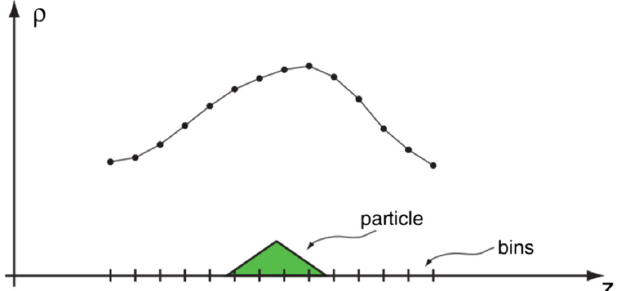
22. Bmad implementation of CSR. The bunch is divided into N b bins in the longitudinal direction for calculation of CSR